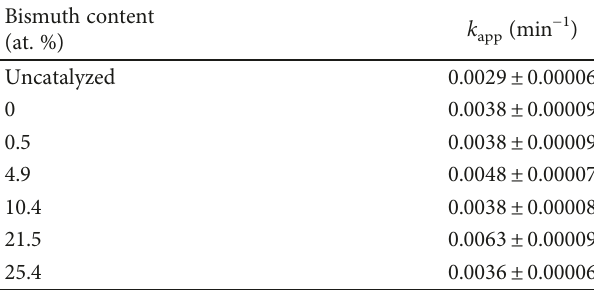
Table 3: Kinetic rate constant ( k as a function of bismuth content, determined using a least square data treatment